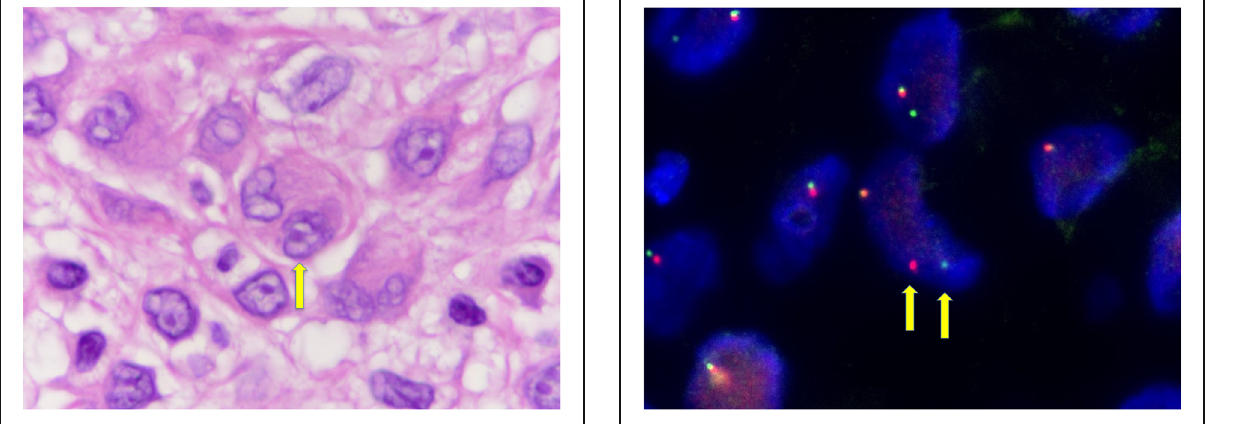
Fig. 6 FISH analysis of ALK rearrangement showing split 3 ’ ALK (orange) and 5 ’ ALK (green) signals